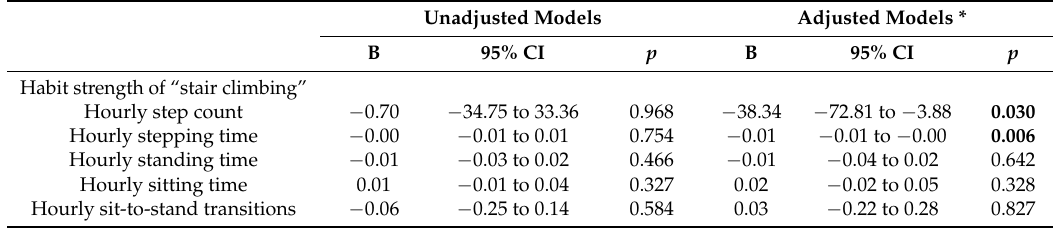
Table 3. Median habit scores for “stair-climbing” as predictors of objective physical activity measures. Unadjusted Models Adjusted Models